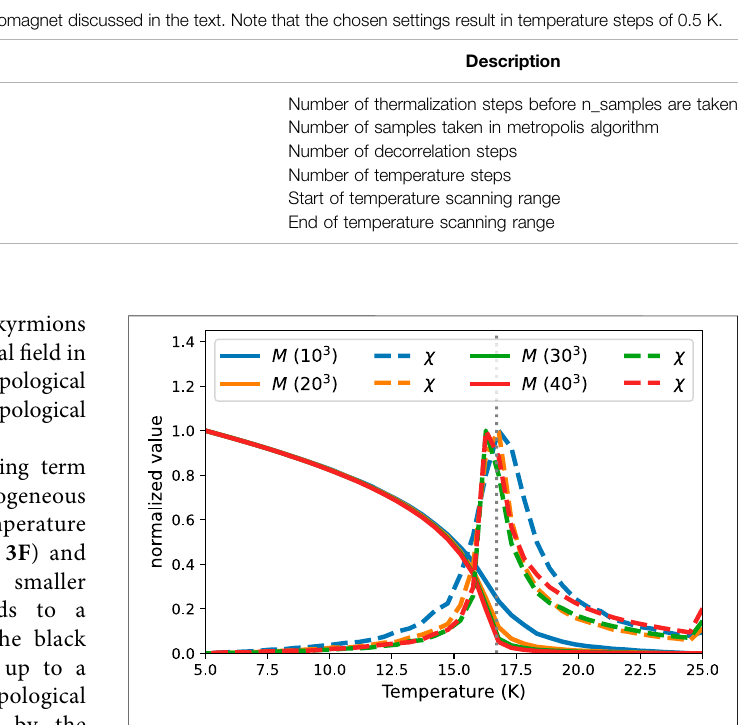
FIGURE 4 | Results of the Monte Carlo calculations for a simple-cubic ferromagnetic with nearest neighbor J 1 = 1 meV exchange interactions. Shown are results for 10 × 10 × 10 to 40 × 40 × 40 supercells where the solid lines show the normalized value of the total magnetization M and the dashed lines the corresponding susceptibility χ . The dashed vertical line indicate the expected value of the critical temperature at T c = 16.71